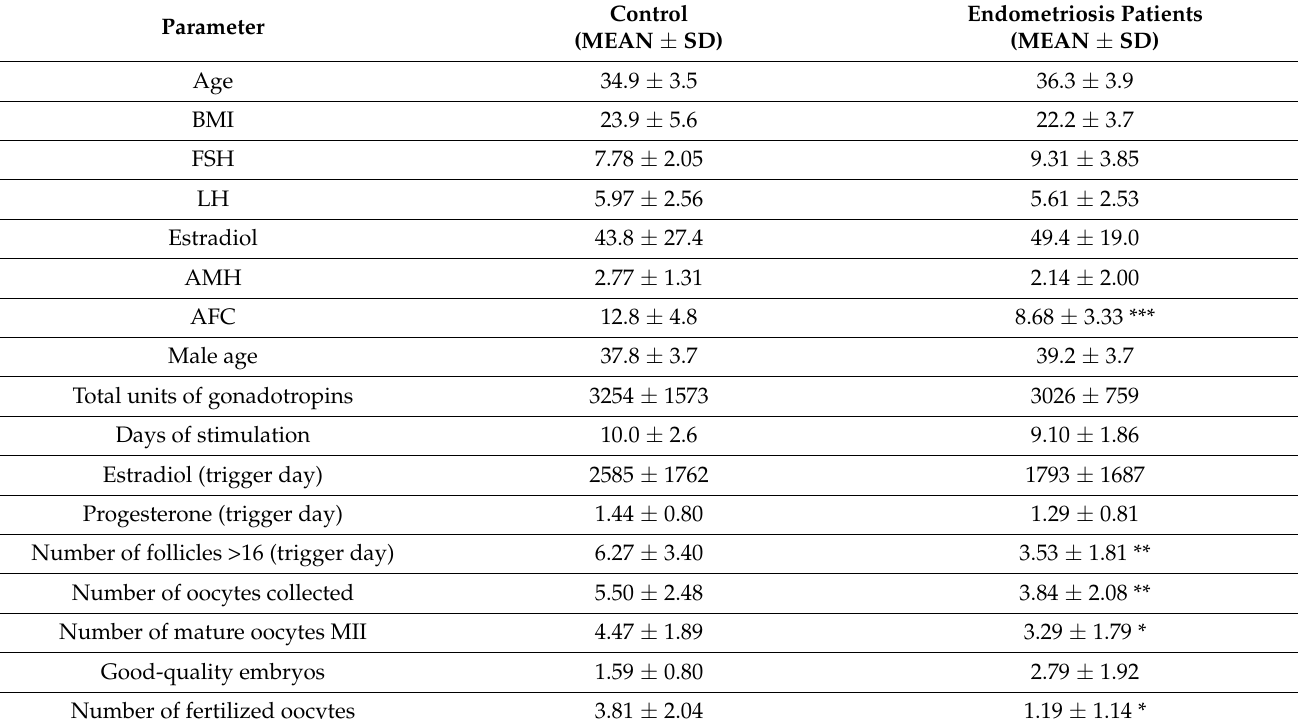
Table 1. Descriptive statistics of clinical parameters for control women and patients with endometriosis. The data are expressed as mean ± SD. Statistical analysis was performed by unpaired t -test. * p < 0.05, ** p < 0.01, *** p < 0.001 vs. control